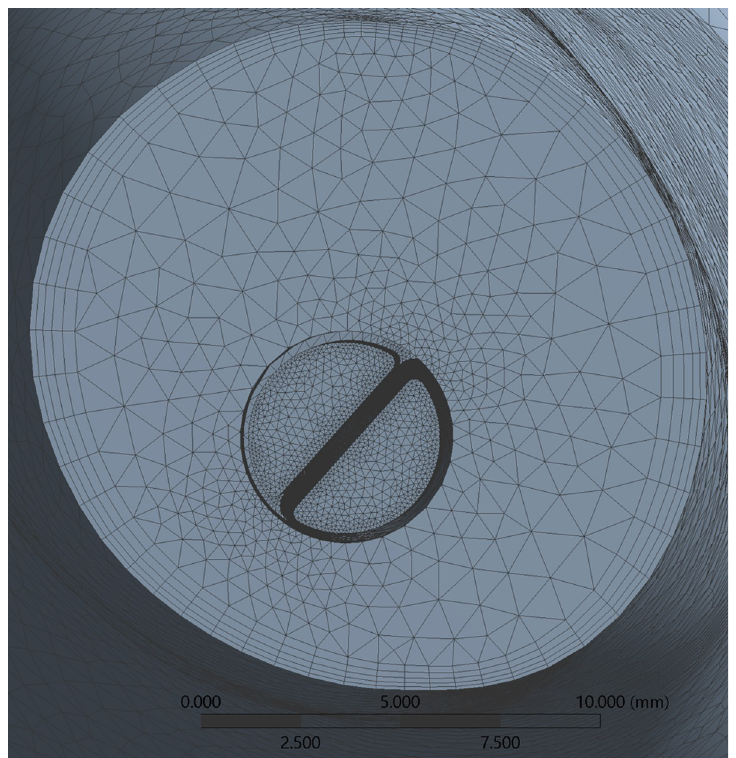
Fig 5. Finite-element mesh cross-section of catheter B inserted in RA.